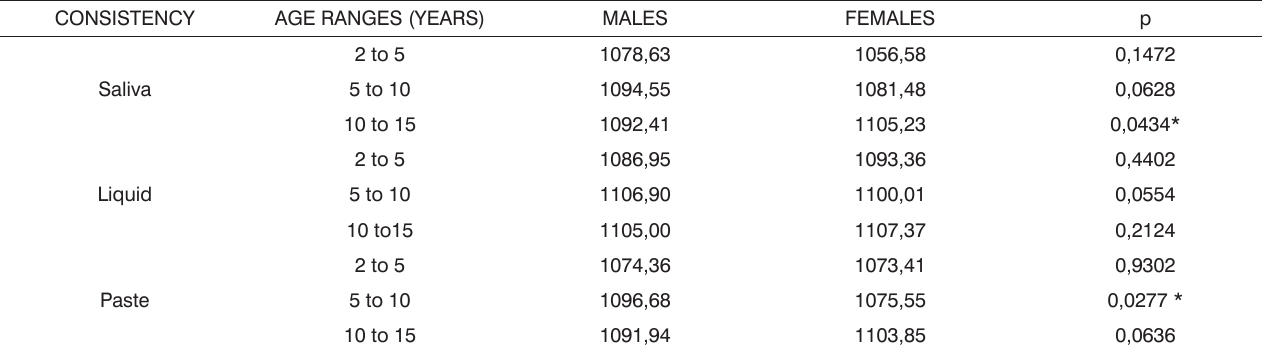
Table 2. Mean values and results from the peak frequency comparison tests according to gender. CONSISTENCY